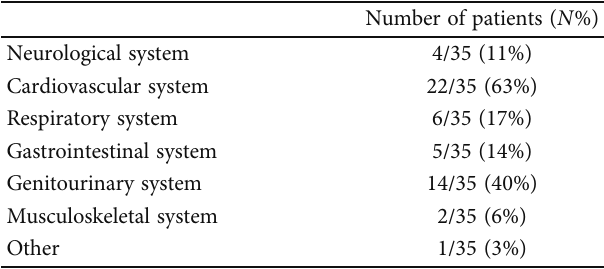
Table 3: Associated congenital anomalies by involved system (some children have multiple anomalies).